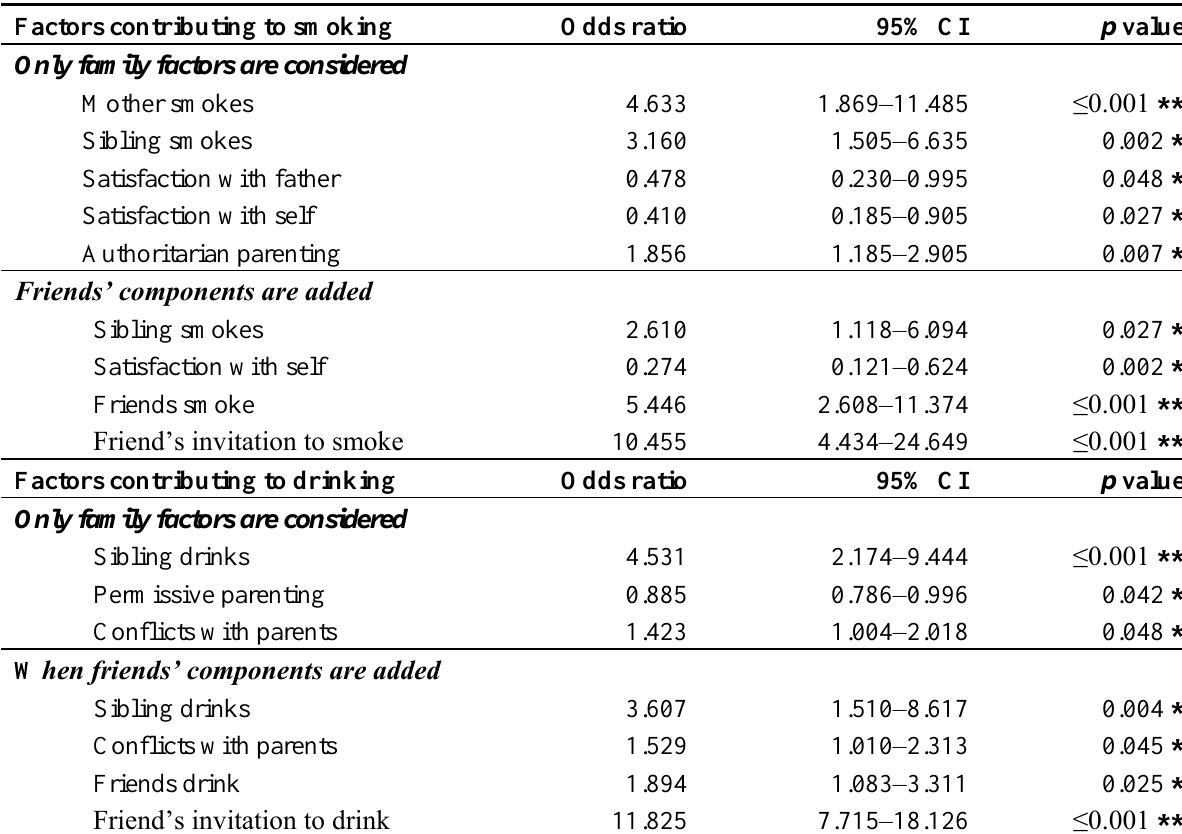
Table 4. Logistic regression analysis # of risk behaviors of adolescents (smoking cigarettes &